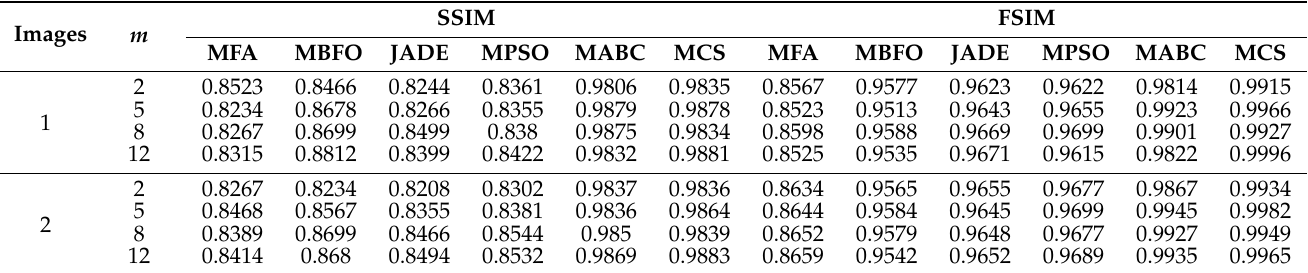
Table A10. SSIM and FSIM computed by different algorithms using the proposed R é nyi-MCS.